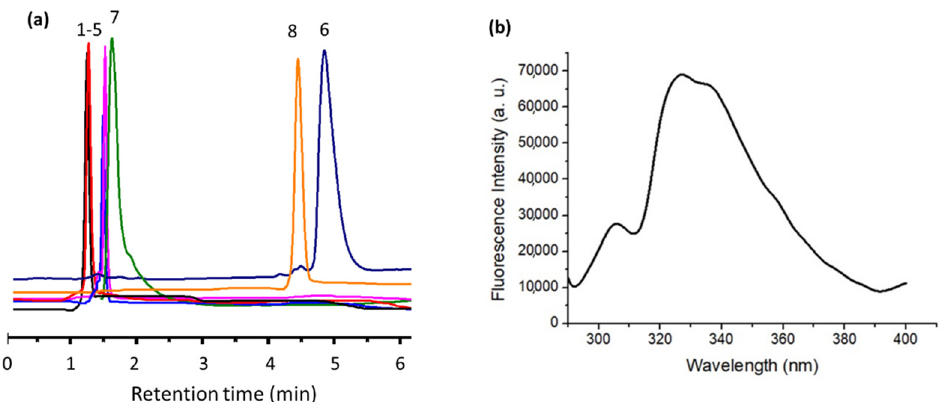
Figure 3. Properties of the macrocycles. ( a ). Reverse-phase high-performance liquid chromatography (RP-HPLC) traces of MC1–8. (Acetonitrile and water with 0.1% formic acid were used as the eluting solvent. The compounds were eluted over 15 min in 5–95 % acetonitrile in water.); ( b ). Fluorescence spectrum of 10 µ M MC8 in methanol upon excitation with a wavelength of 278